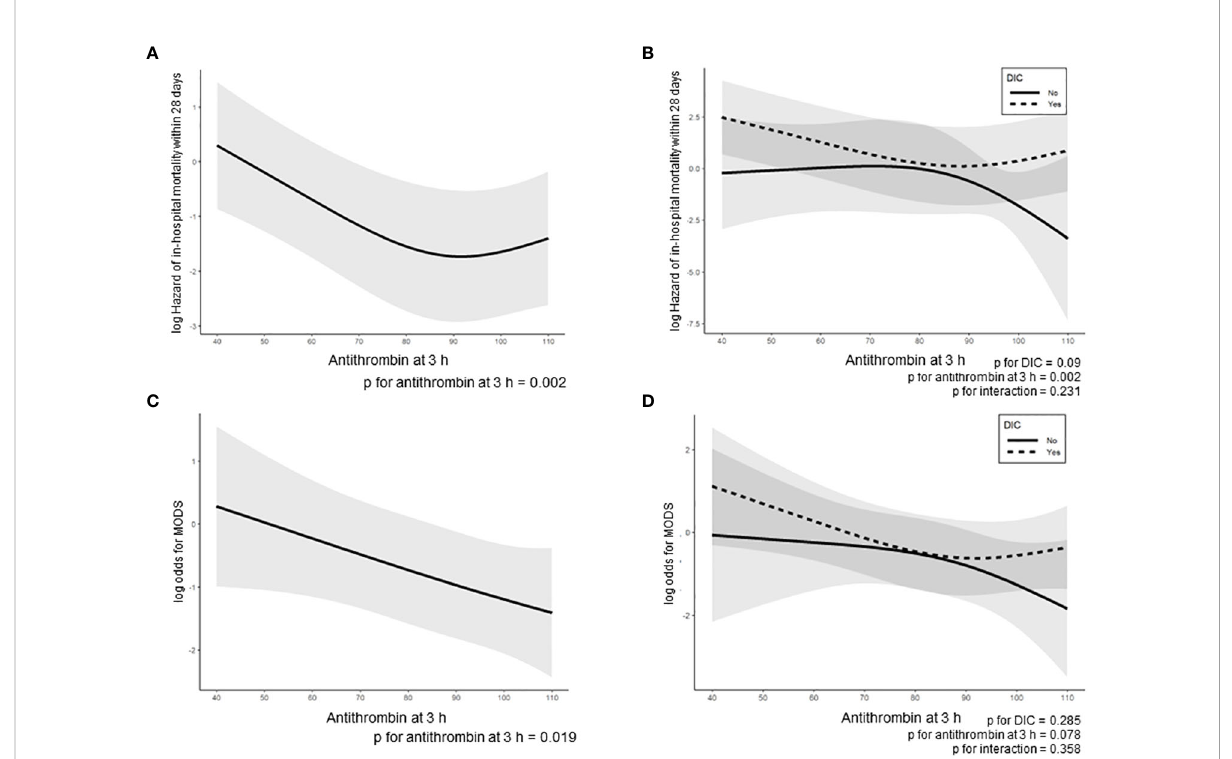
FIGURE 3 Regression line of in-hospital mortality in all enrolled trauma patients was dependent on antithrombin activity at 3 h, as estimated by the Cox proportional hazard regression model (A, B) and a two-way interaction term between the antithrombin activity at 3 h and the presence or absence of DIC onset during the 24 h after hospital arrival (B) . Regression line of the development of MODS during the 24 h after admission based on the multivariable logistic regression model (C, D) and a two-way interaction term between the antithrombin activity at 3 h and the presence or absence of DIC onset during the 24 h after hospital arrival (D) . The lines indicate estimated log-transformed relative hazards or odds, and the shaded areas represent 95% con fi dence intervals. In 3B and 3D, dotted and solid lines represent the patients with and without DIC, respectively. DIC, disseminated intravascular